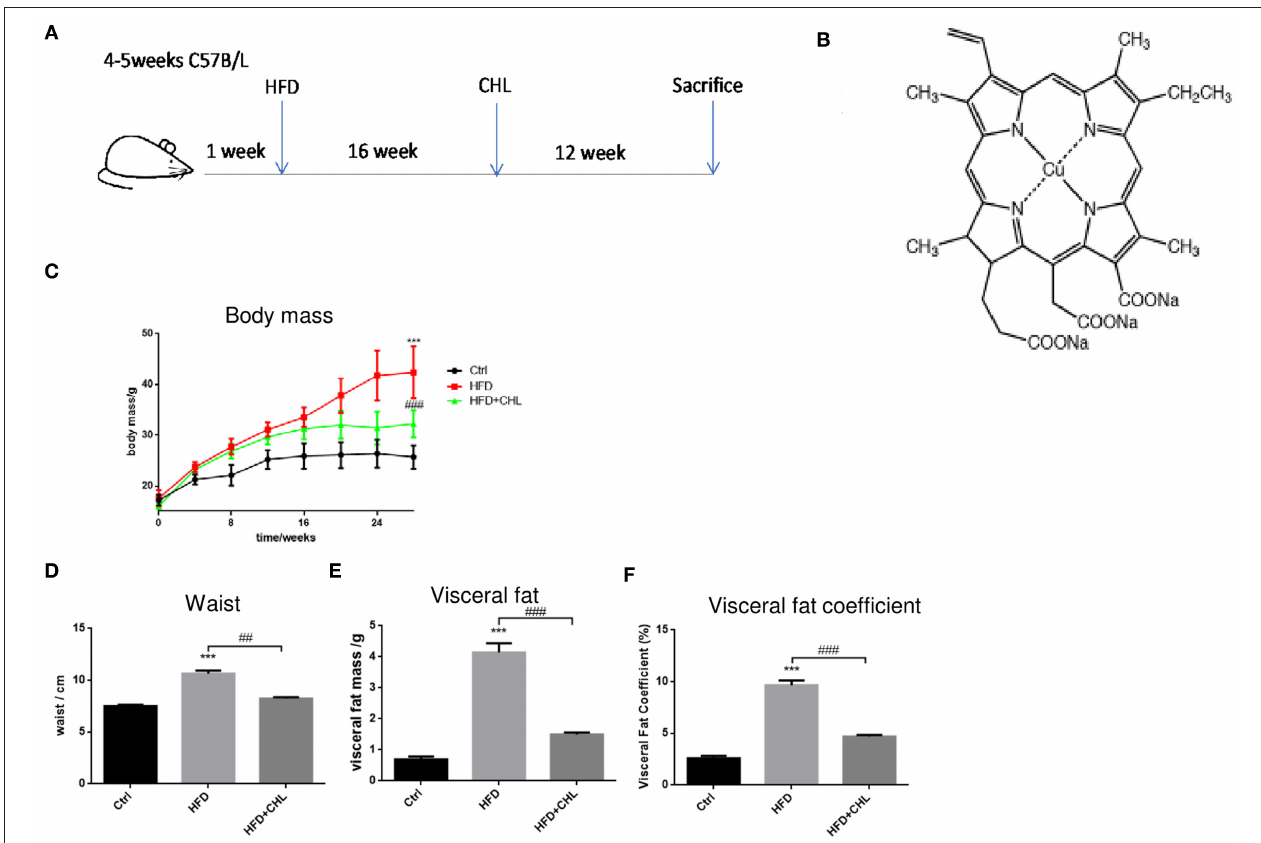
FIGURE 1 | Chlorophyllin (CHL) attenuates body weight gain by high fat feeding in mice. (A) B57BL/6 male mice were randomly divided into three groups: control group, fed with AIN93 chow; high fat diet (HFD) group, by which 65% calorie comes from animal fat; HFD + CHL group, by which the mice were fed with HFD for 16 weeks followed by adding CHL (30 mg/L) in drinking water for another 12 weeks. (B) Structure of CHL. (C) Changes in body mass. (D) Changes in waist size. (E) Total visceral fat. (F) Visceral fat co-efficiency, visceral fat/body weight. n = 6–8 for each group. Values are mean ± SEM; *** p < 0.001 vs. Ctrl group; ## p < 0.01, ### p < 0.001 vs. HFD